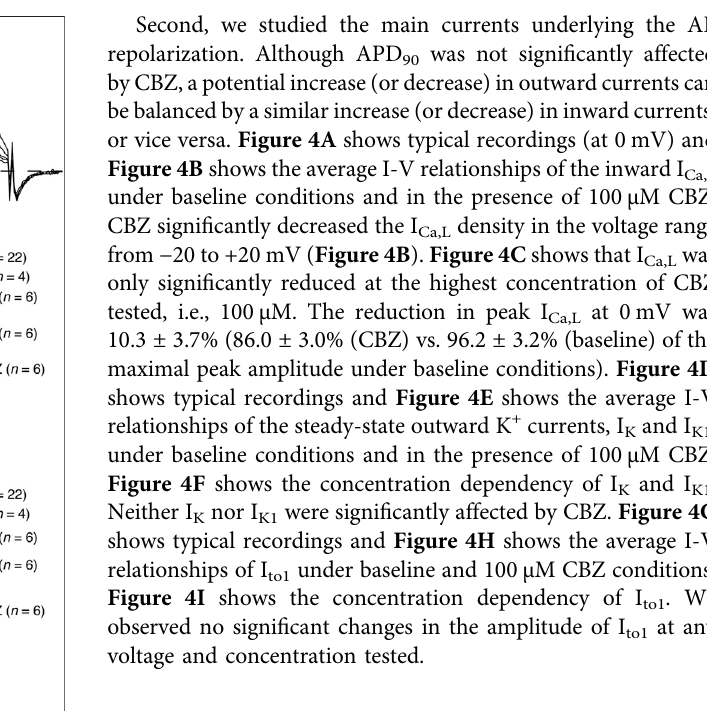
baseline conditions and in the presence of 100 µM CBZ. While CBZ did not affect the voltage dependency of activation, the voltage dependency of inactivation was signi fi cantly shifted to more negative membrane potentials. On average, the negative shift in V 1/2 was 6.2 ± 1.3 mV ( − 90.4 ± 1.8 (CBZ) vs. − 84.3 ± 1.0 mV (baseline)), while the slope of the inactivation curve was not signi fi cantly different between baseline ( − 5.0 ± 0.9 mV) and CBZ ( − 5.4 ± 0.7 mV). Figures 3E,F , show the recovery from inactivation of I Na , with in Figure 3E typical I Na recordings (bottom) obtained in response to a double-pulse protocol (top) with an interpulse interval of 100 ms, and in Figure 3F the average data with all interpulse intervals tested. CBZ results in a severe delay in the recovery from inactivation. For example, with an interpulse interval of 100 ms, recovery from inactivation was as large as 78.1 ± 4.5% at baseline, but only 15.4 ± 3.1% in the presence of CBZ.